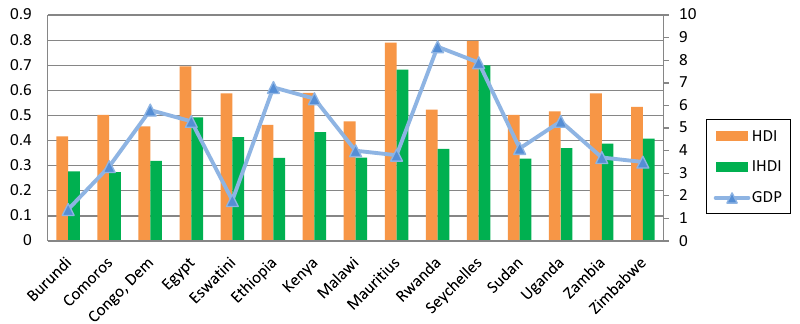
Figure 2. GDP growth rate, HDI and IHDI